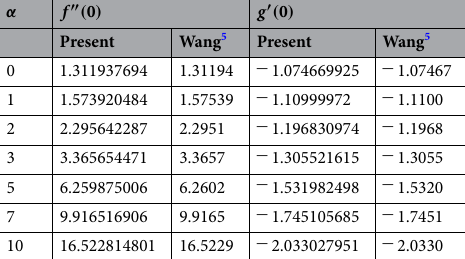
Table 1. f ′′ ( 0 ) and g ′ ( 0 ) for various α when M = 0